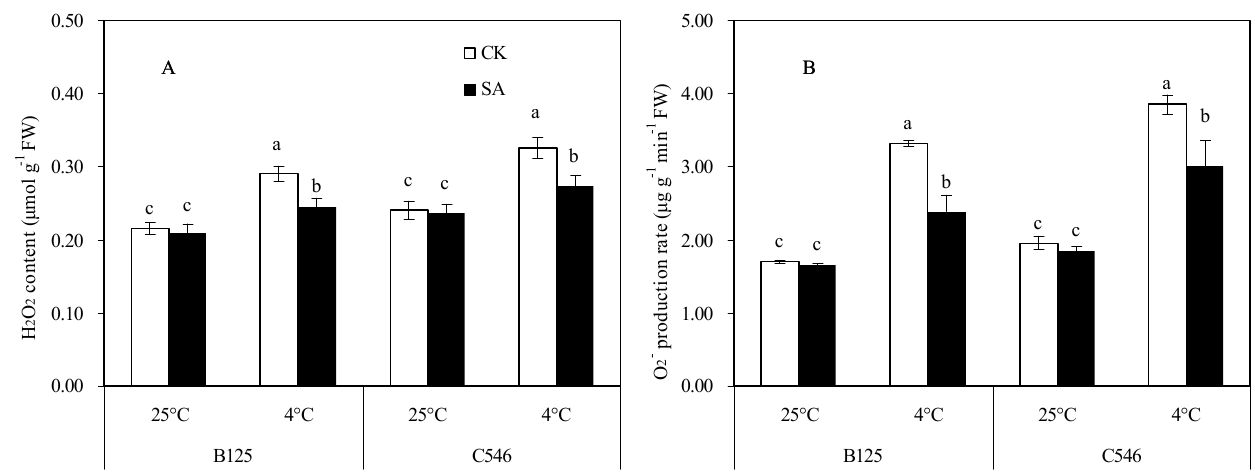
Figure 4. Effects of SA treatment on H 2 O 2 content ( A ) and O 2 − production rate ( B ) in C546 and B125 maize seedlings. The plants were treated at 4 °C for 2 days. The different letters indicate significant differences between different SA concentrations under two temperatures within the same inbred line at p < 0.05.